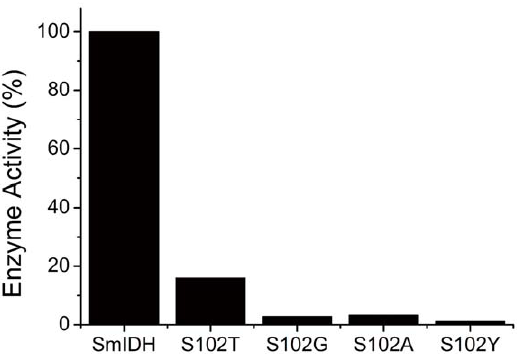
Figure 6. The residual activities of the four Ser102 mutants as compared to the wild-type